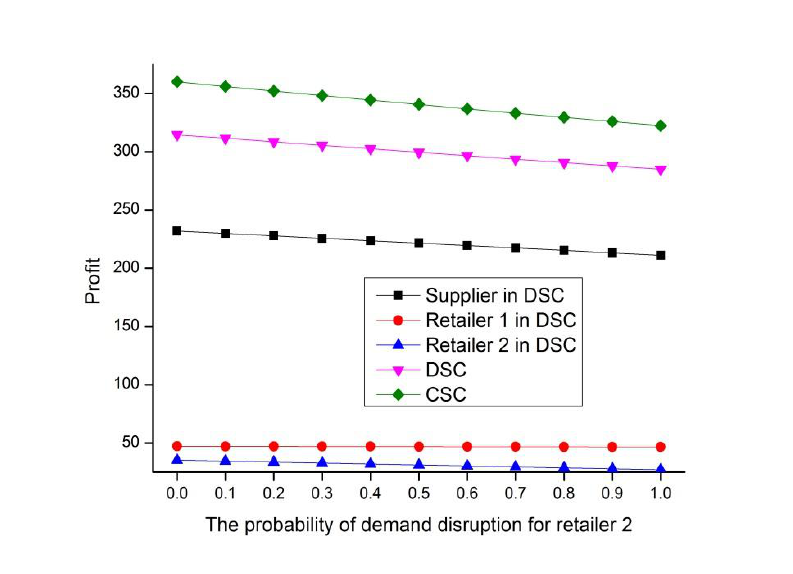
Figure 4. The profit versus the probability of demand disruption for retailer